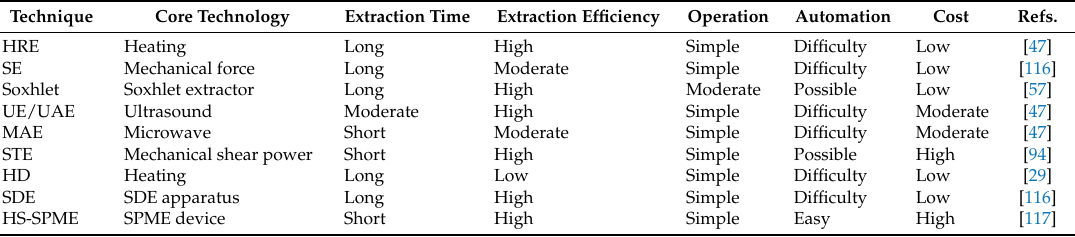
Table 2. Characteristics of different extraction